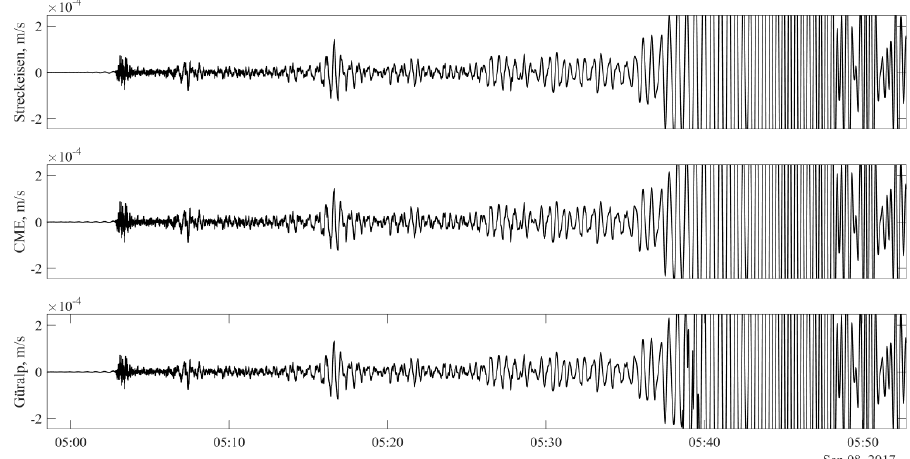
Figure 2. Typical amplitude-frequency response (AFR) and phase-frequency response (PFR) of Streckeisen STS-1V/VBB (dash-dotted line), Güralp CMG-3ESP (dotted lines), and СМЕ-4211V (solid lines) devices.